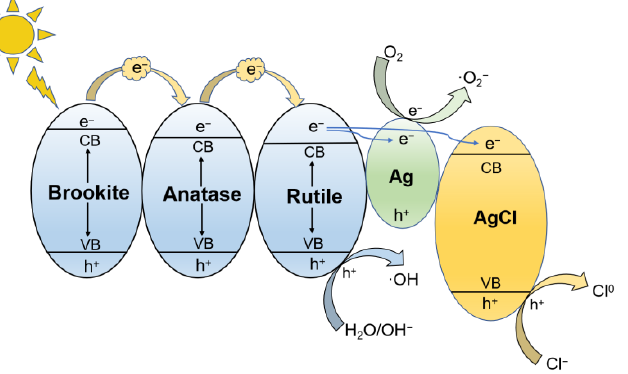
Figure 11. The energy band structure and the diagram of photogenerated charge transfer of Ag/AgCl@TiO 2 .